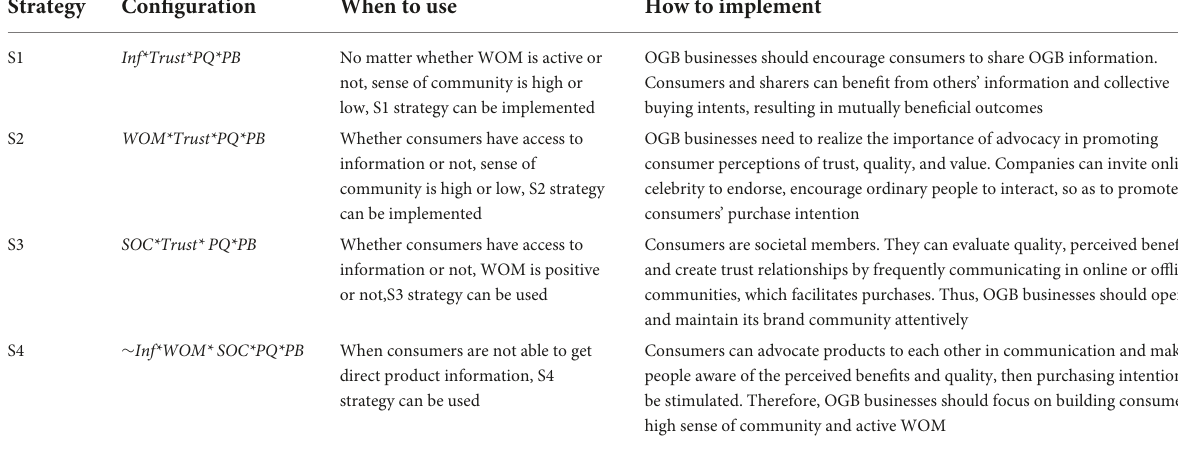
TABLE 6 Key implications of the